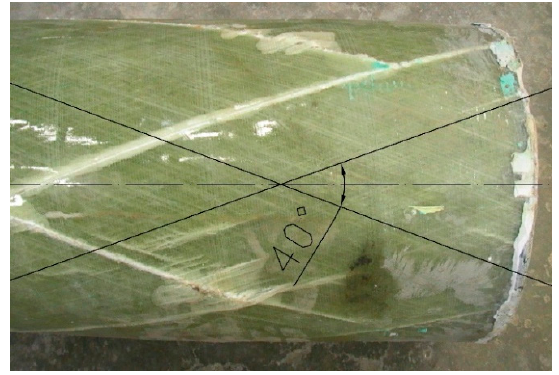
Figure 4. Measurement of fiber winding angle for pipe with declared winding angle 20°.